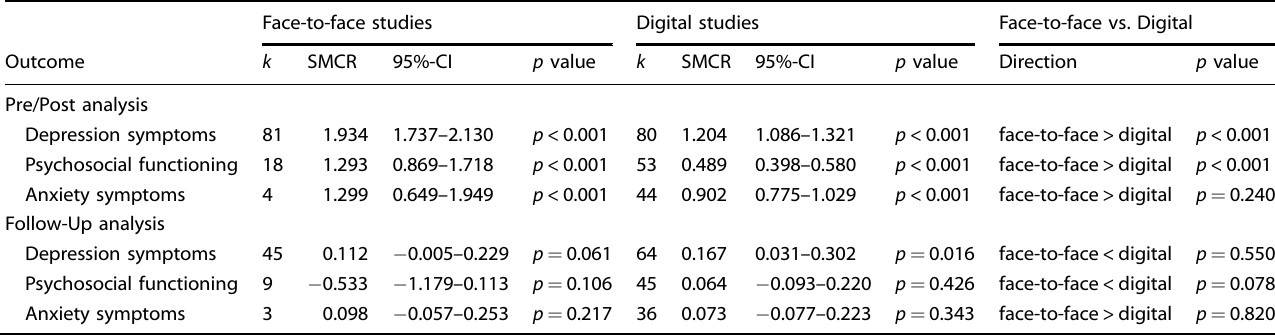
Table 2. Results of meta-analyses investigating pre/post effects and long-term stability of treatment gains for digital and face-to-face CBT interventions. P values indicate signi fi cance of meta-analytic summary effect sizes (SMCR) testing the difference between symptoms pre- vs. post- intervention. Effect sizes and p values are presented without correction for differences in patient samples or study design characteristics and without correction for potential publication